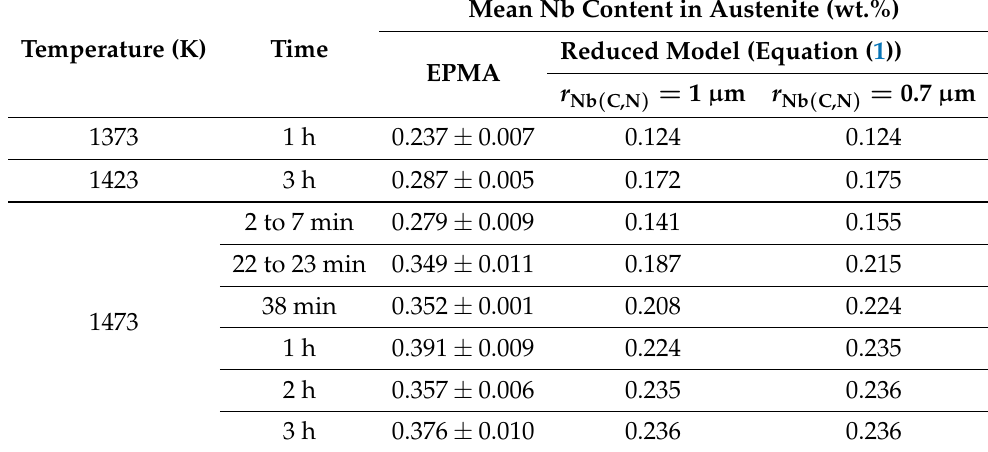
Figure 10. Concentration profiles for Nb in austenite ([Nb]) obtained by EPMA after heat treatments: ( a ) at different temperatures for close time durations and ( b ) at 1473 K for different time durations. Table 6. Comparison of mean Nb contents in austenite due to Nb(C,N) evolution during different isothermal heat treatments obtained by EPMA measurements and predicted using the reduced model (Equation (1)) based on DICTRA simulation (nine-element simulation using TCFE9). Intervals represent the variability between different measurements for the same